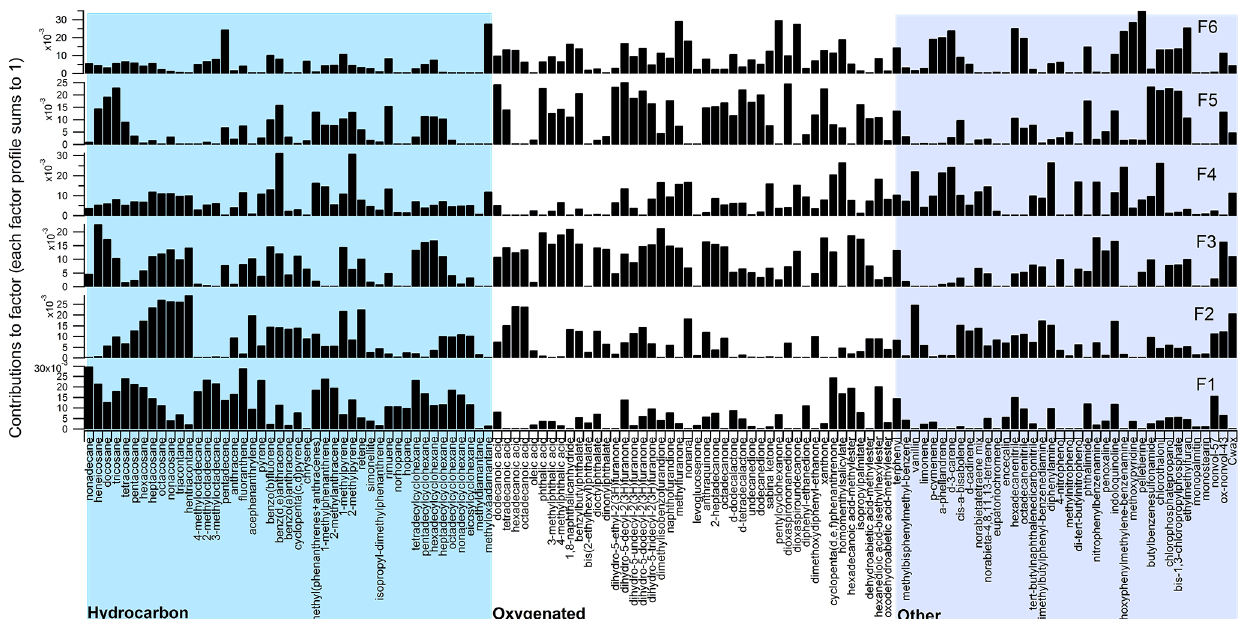
Figure 8. Profiles of the TAG–Integrated six-factor